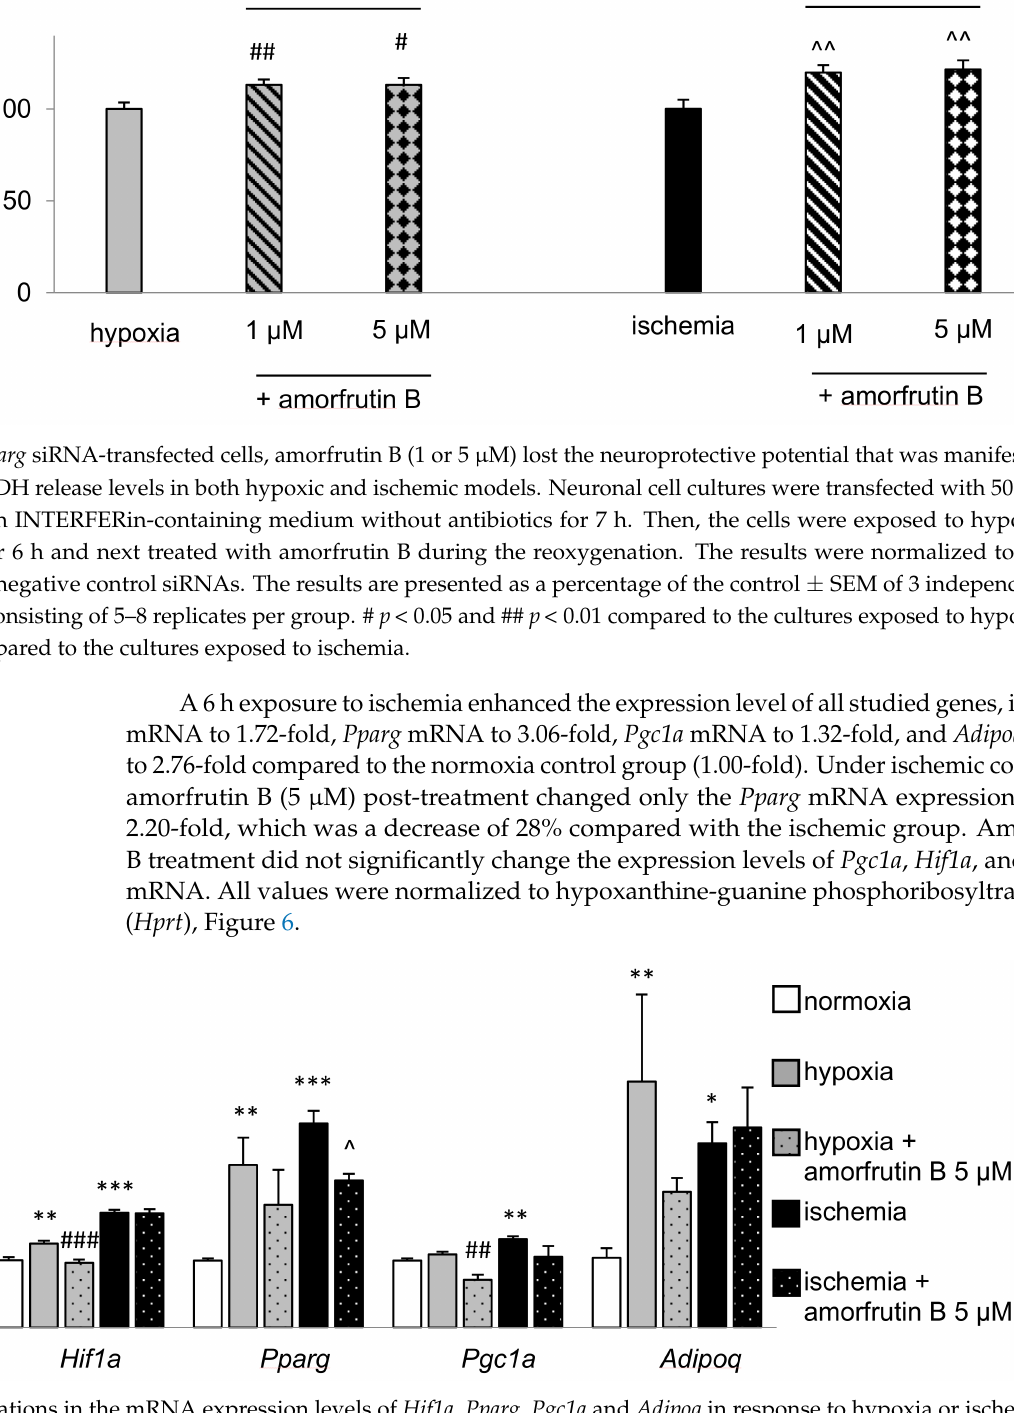
Figure 6. Alterations in the mRNA expression levels of Hif1a , Pparg , Pgc1a and Adipoq in response to hypoxia or ischemia and amorfrutin B (5 µ M) treatment in neocortical cell cultures. The results are presented as a mean ± SEM. There were 3 independent experiments, consisting of 6 replicates per group. * p < 0.05, ** p < 0.01, and *** p < 0.001 compared to the control group, ## p < 0.01, ### p < 0.001 compared to the cultures exposed to hypoxia, ˆ p < 0.05 compared to the cultures exposed to